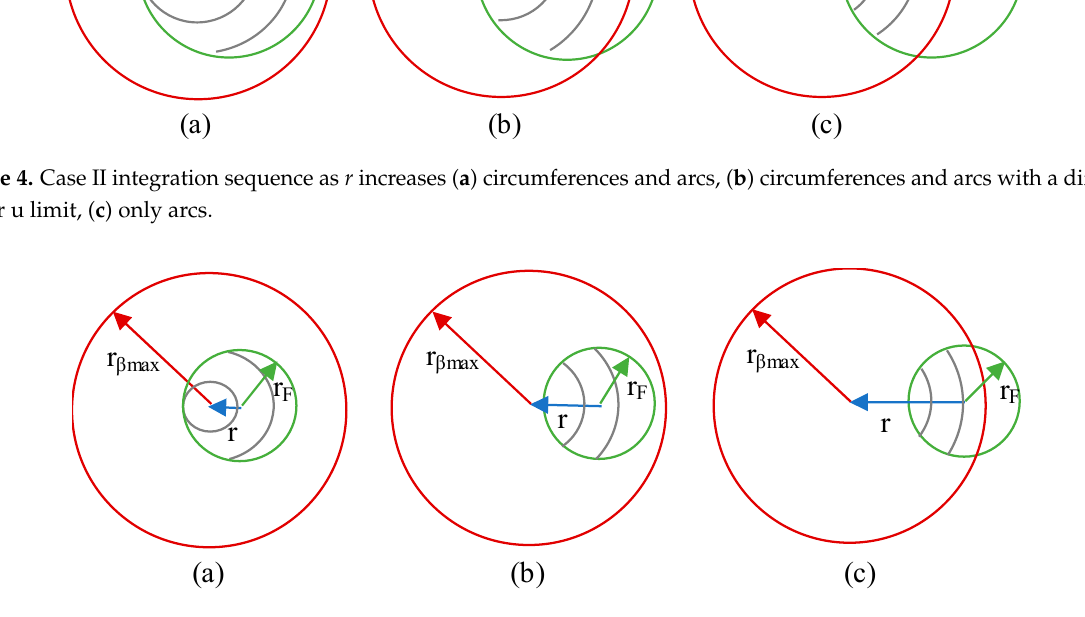
Figure 5. Case III integration ( a ) circumferences and arcs, ( b ) only arcs, ( c ) only arcs with a different upper u limit.